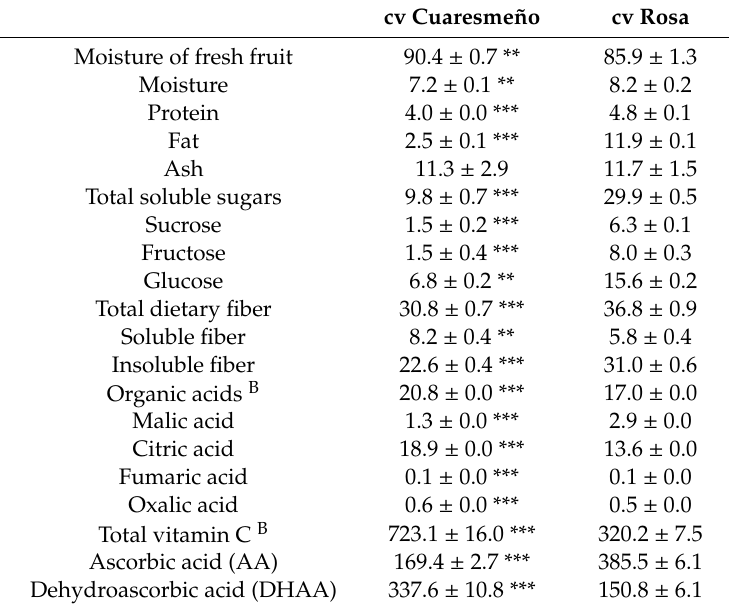
Table 1. Nutritional composition of two cultivars of xoconostle A